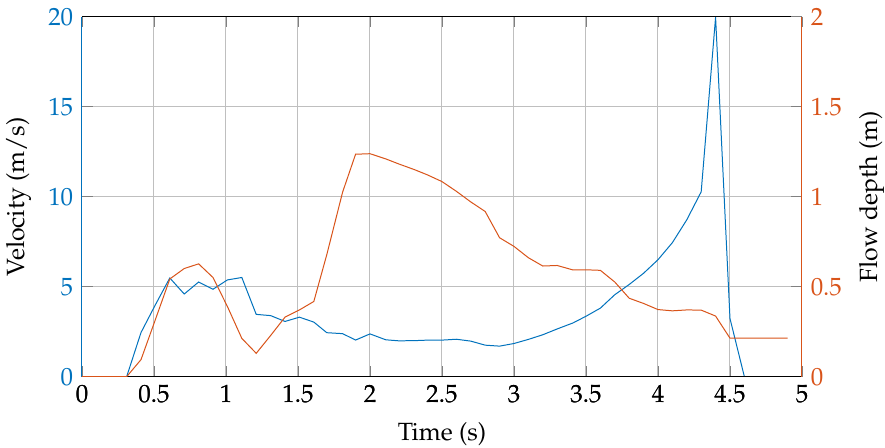
Figure 11. Modelled flow depth and velocity on landward side of structure for the maximum individual overtopping event during Storm